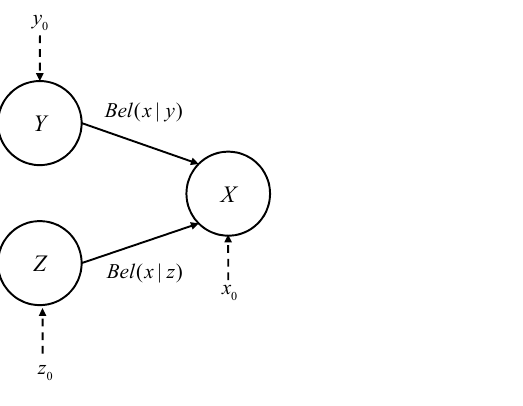
Figure 4. Evidence network under the conditional belief parameter model.